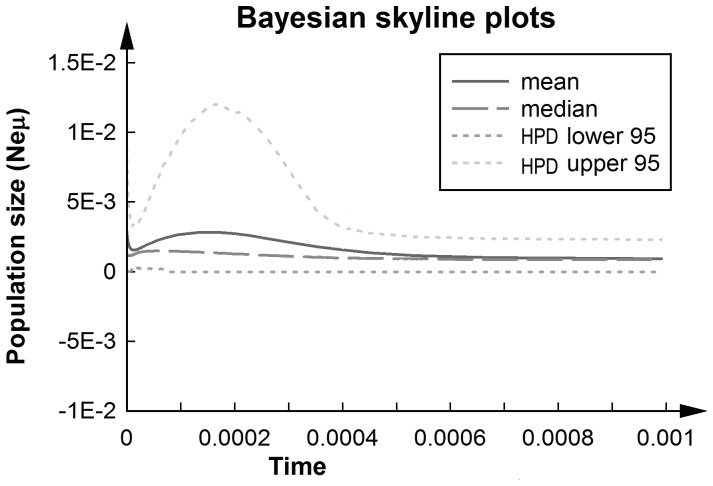
Bayesian skyline plot of effective population size (scaled by mutation rate) through time.Estimates are shown along with the union of the 95% highest posterior density (HPD) areas. Note that the time scale begins with the present on the left and is given in substitutions per site, which can be converted to units of time via a molecular clock calibration.